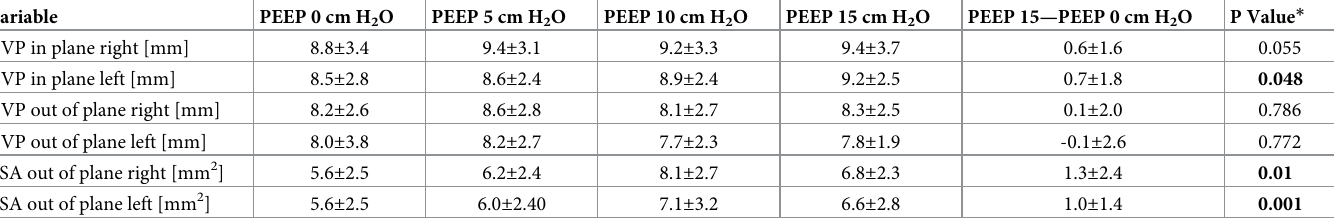
Table 1. Distance between subclavian vein and parietal pleura and cross-sectional area of the subclavian vein measured during different PEEP settings.